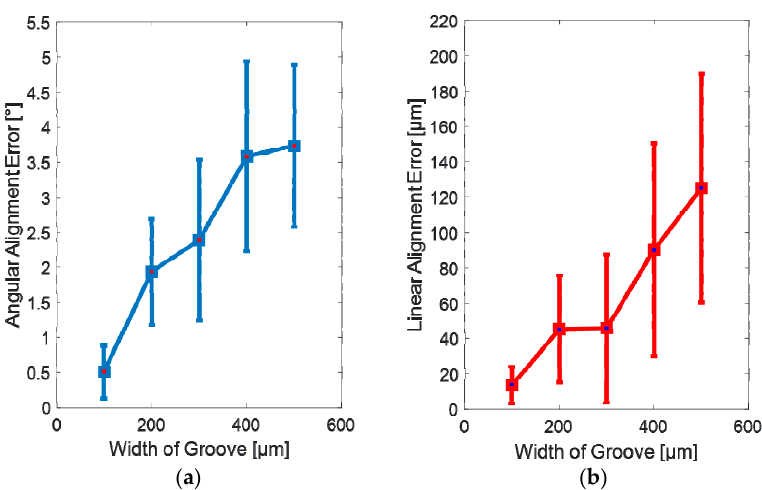
Figure 8. The influence of the width of the groove on the alignment accuracy: ( a ) Angular alignment